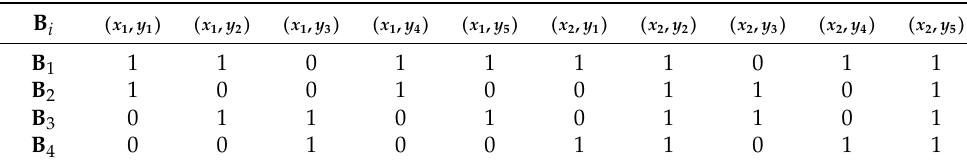
Table 4. The bit string B i for the example dataset D of Table 3. Each column ( x p , y q ) is 0 if x p ( F i )